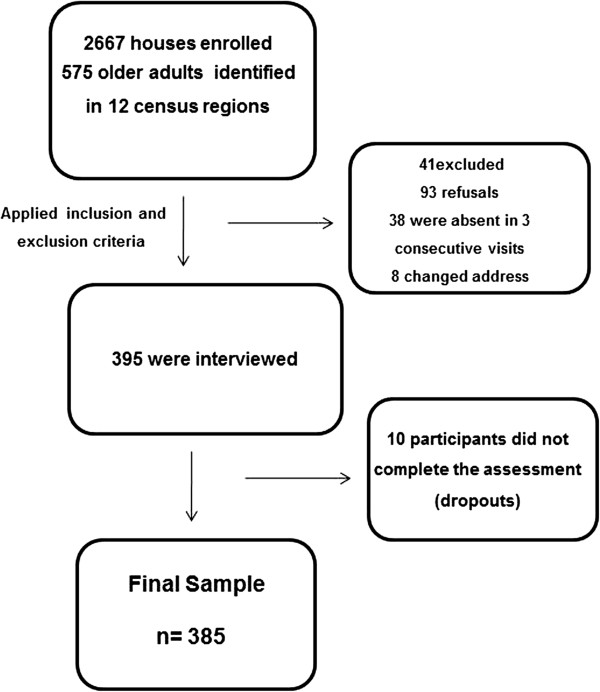
Flowchart of study sample.